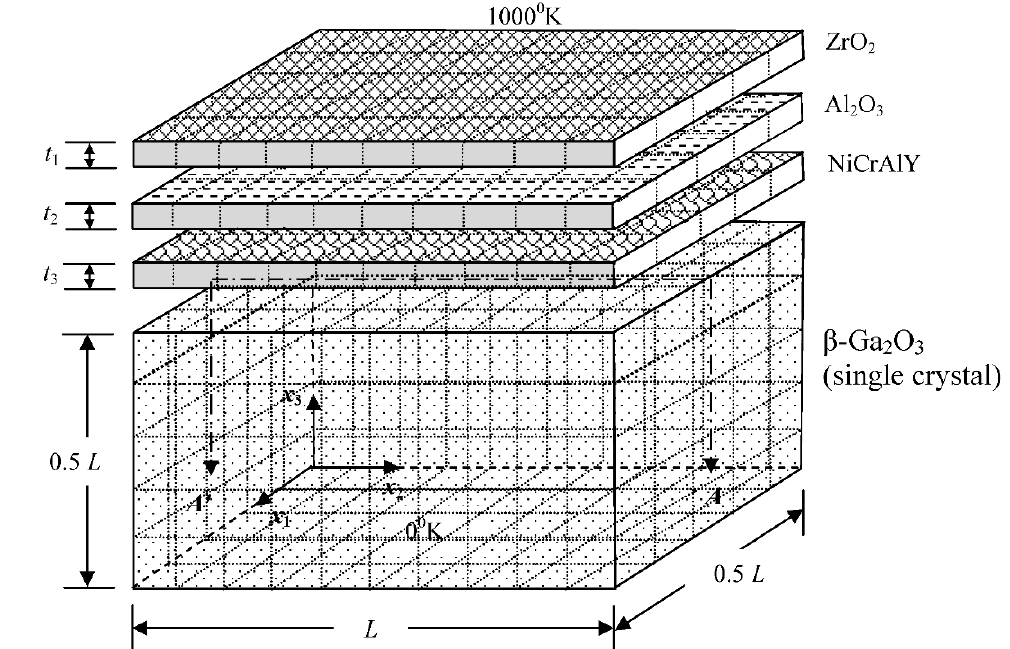
Figure 5. A typical coated medium subjected to high temperature on top (not drawn to scale).